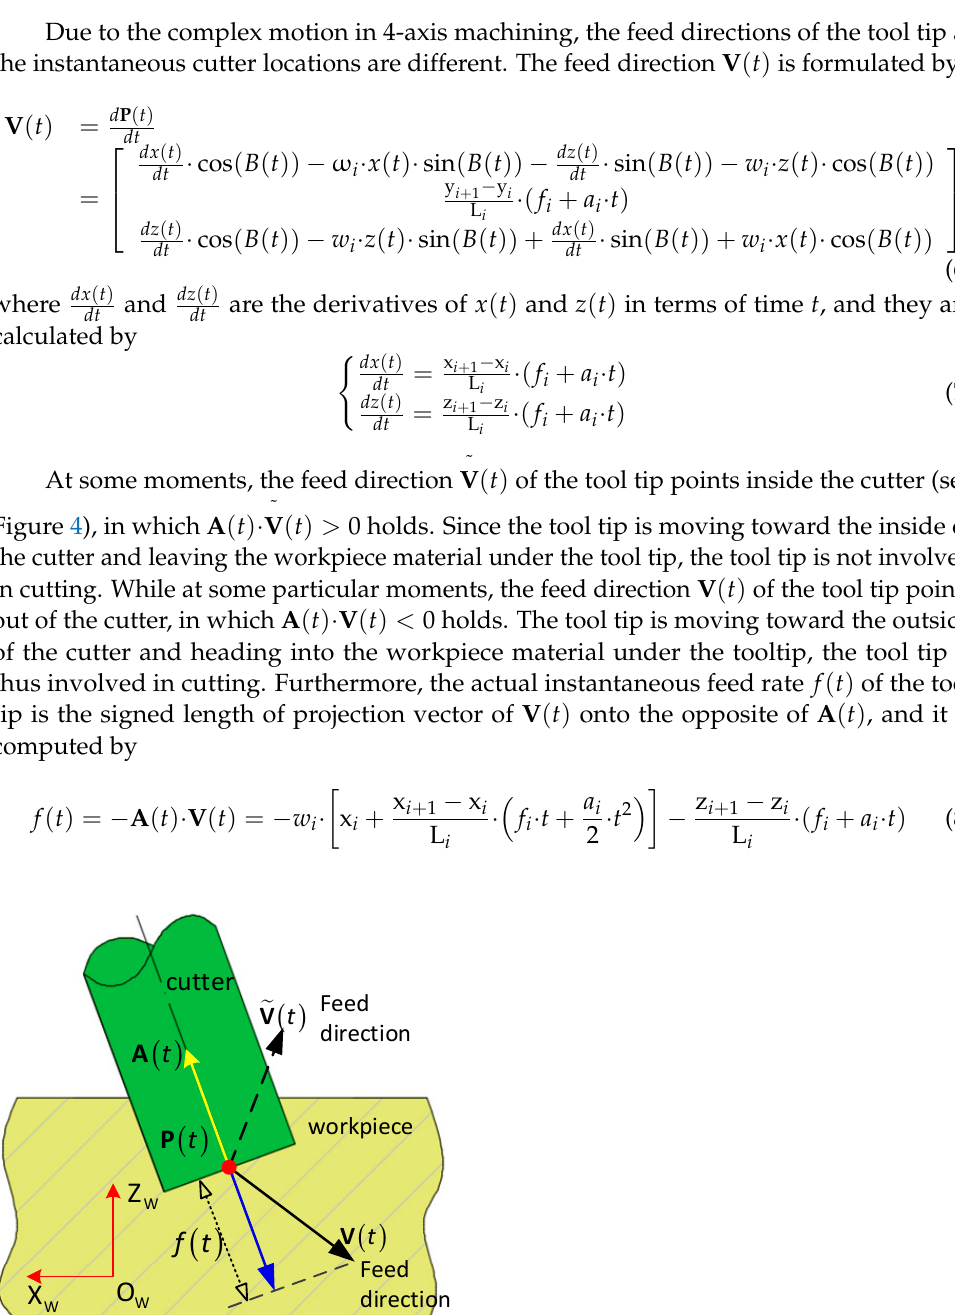
Figure 5. A number of instantaneous feed rates of the tool tip on a step are sampled and the maxi- mum instantaneous bottom edge feed rate is determined. To evaluate the bottom edge cutting, a number of instantaneous feed rates of the tool tip on a step are sampled. The maximum of them is called the maximum instantaneous bottom edge feed rate on the step, and it is denoted as